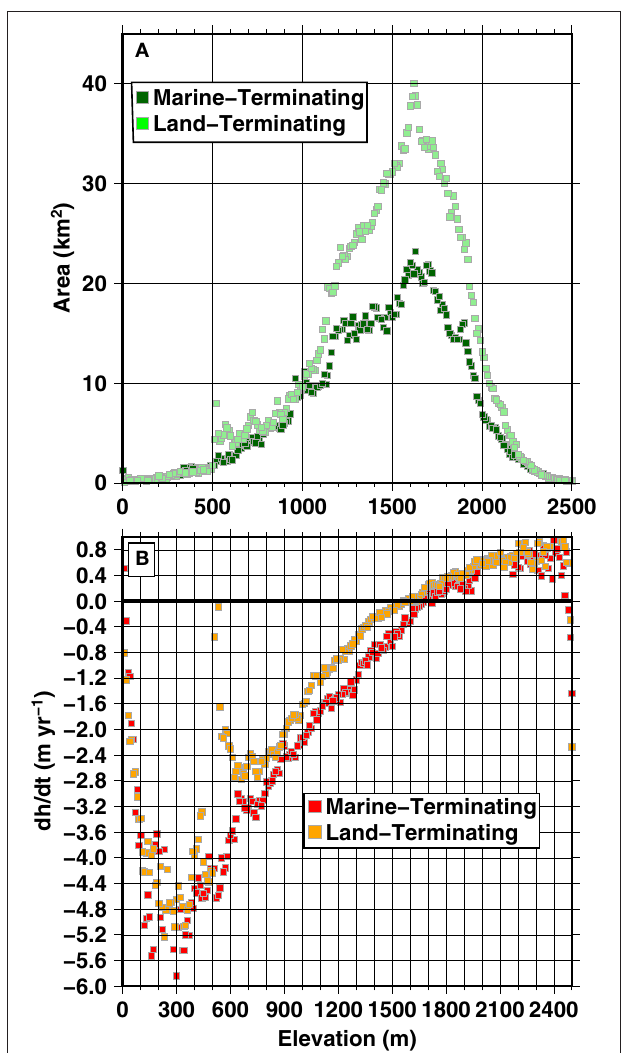
FIGURE 3 | Hypsometry (A) and dh dt by elevation (B) for marine- and land-terminating glaciers on the Stikine Icefield using dh dt between 2000 and 2013/2014 calculated from stacked ASTER DEMs and the SRTM DEM. Note that the minimum dh dt is not always at the lowest elevation, both because the dh dt becomes zero in areas of retreat as well as the fact that there are few data points at low elevation (A) .